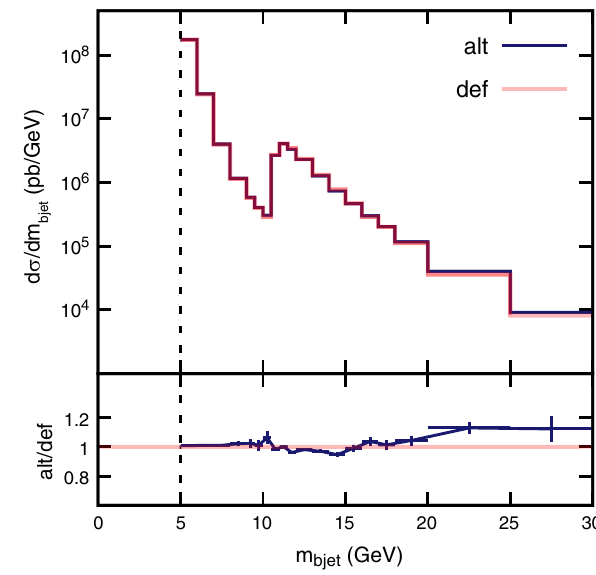
Fig. 8 Comparison of alt and def for the transverse momentum distribution of the B hadron at the 8TeV LHC